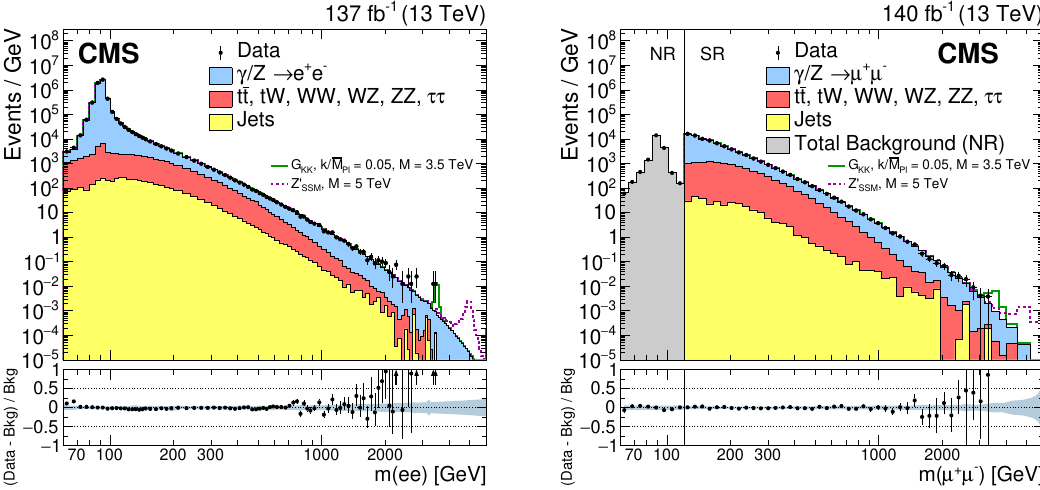
Figure 2 . The invariant mass distribution of pairs of (left) electrons and (right) muons observed in data (black dots with statistical uncertainties) and expected from the SM processes (stacked histograms). For the dimuon channel, a prescaled trigger with a p to collect events in the normalization region (NR) with m threshold is 30 GeV. Events in the signal region (SR) corresponding to masses above 120 GeV are collected using an unprescaled single-muon trigger. The bin width gradually increases with mass. The ratios of the data yields after background subtraction to the expected background yields are shown in the lower plots. The blue shaded band represents the combined statistical and systematic uncertainties in the background. Signal contributions expected from simulated G resonances with masses of 3.5 and 5 TeV, respectively, are